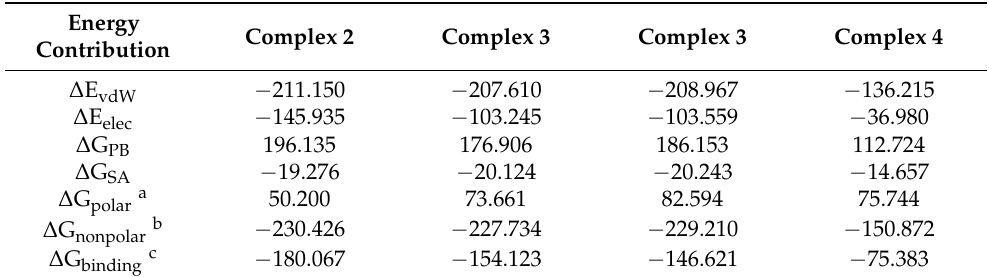
Table 3. Different energy components and binding free energies of the four complexes were calculated by MM/PBSA (kJ · mol − 1